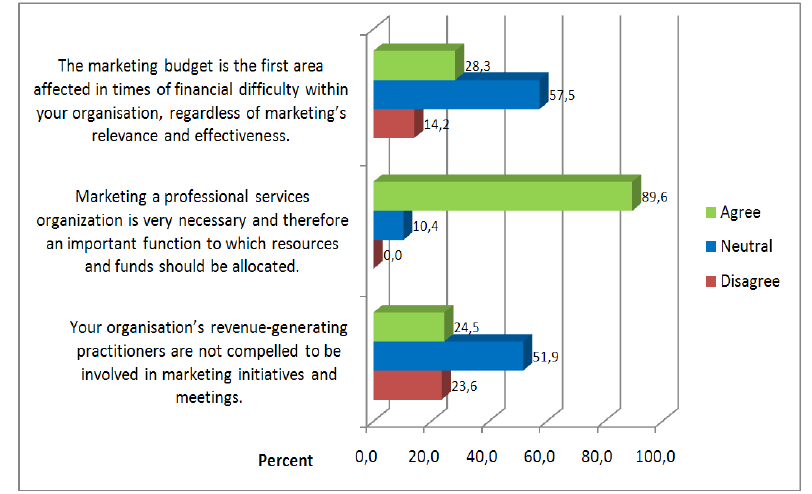
Fig. 10. Respondent scores: